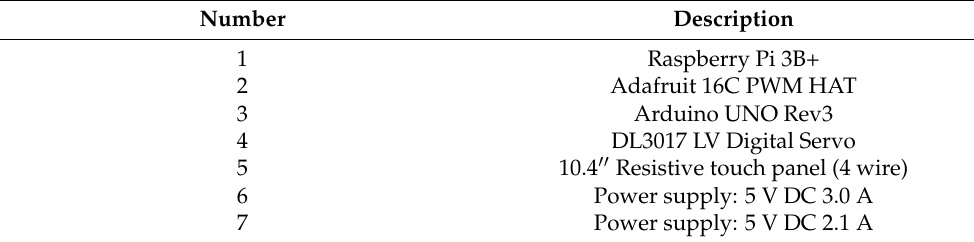
Table 2. Electrical